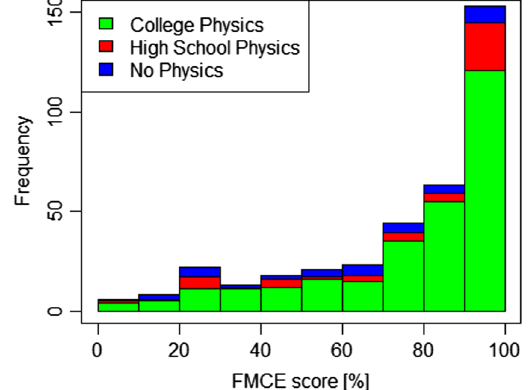
FIG. 7. FMCE postscore by prior physics preparation for students who have taken an AP or college-level physics course in high school (green, N ¼ 286 ), students who took a regular high school physics class (red, N ¼ 51 ), and students with no prior physics (blue, N ¼ 37